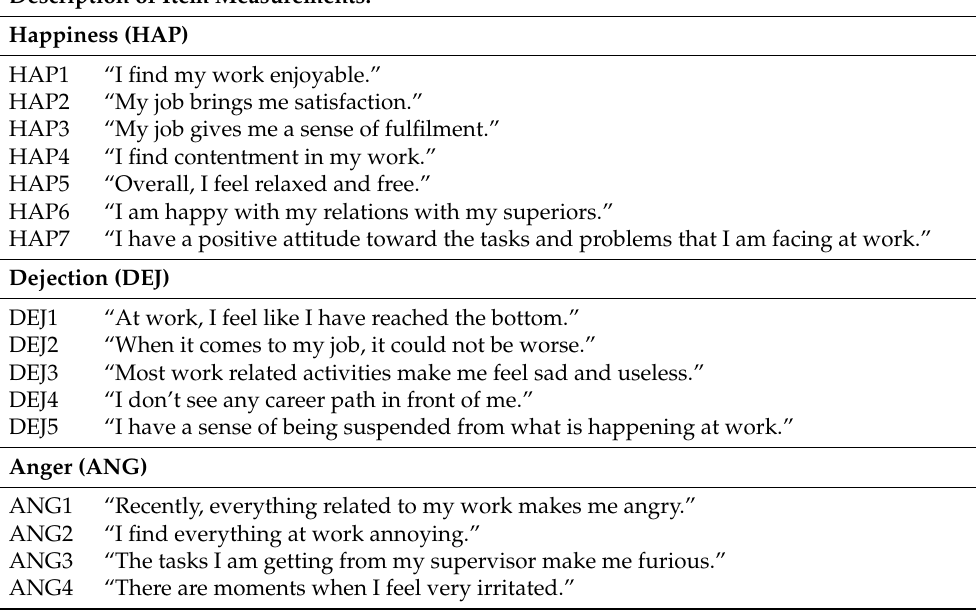
Table 1. Cont . Description of Item